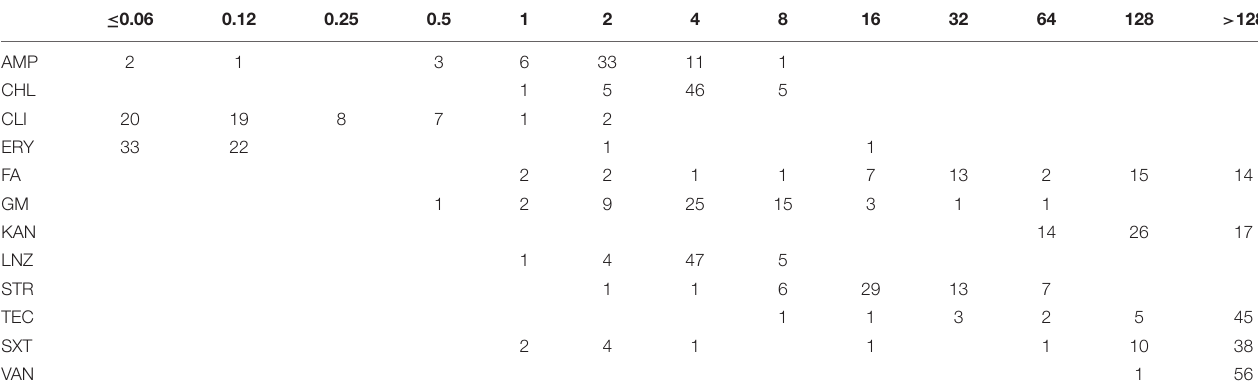
TABLE 2 | Distribution of different antimicrobial agent MICs (mg/l) for 57 Lactobacillus isolates. ≤ 0.06